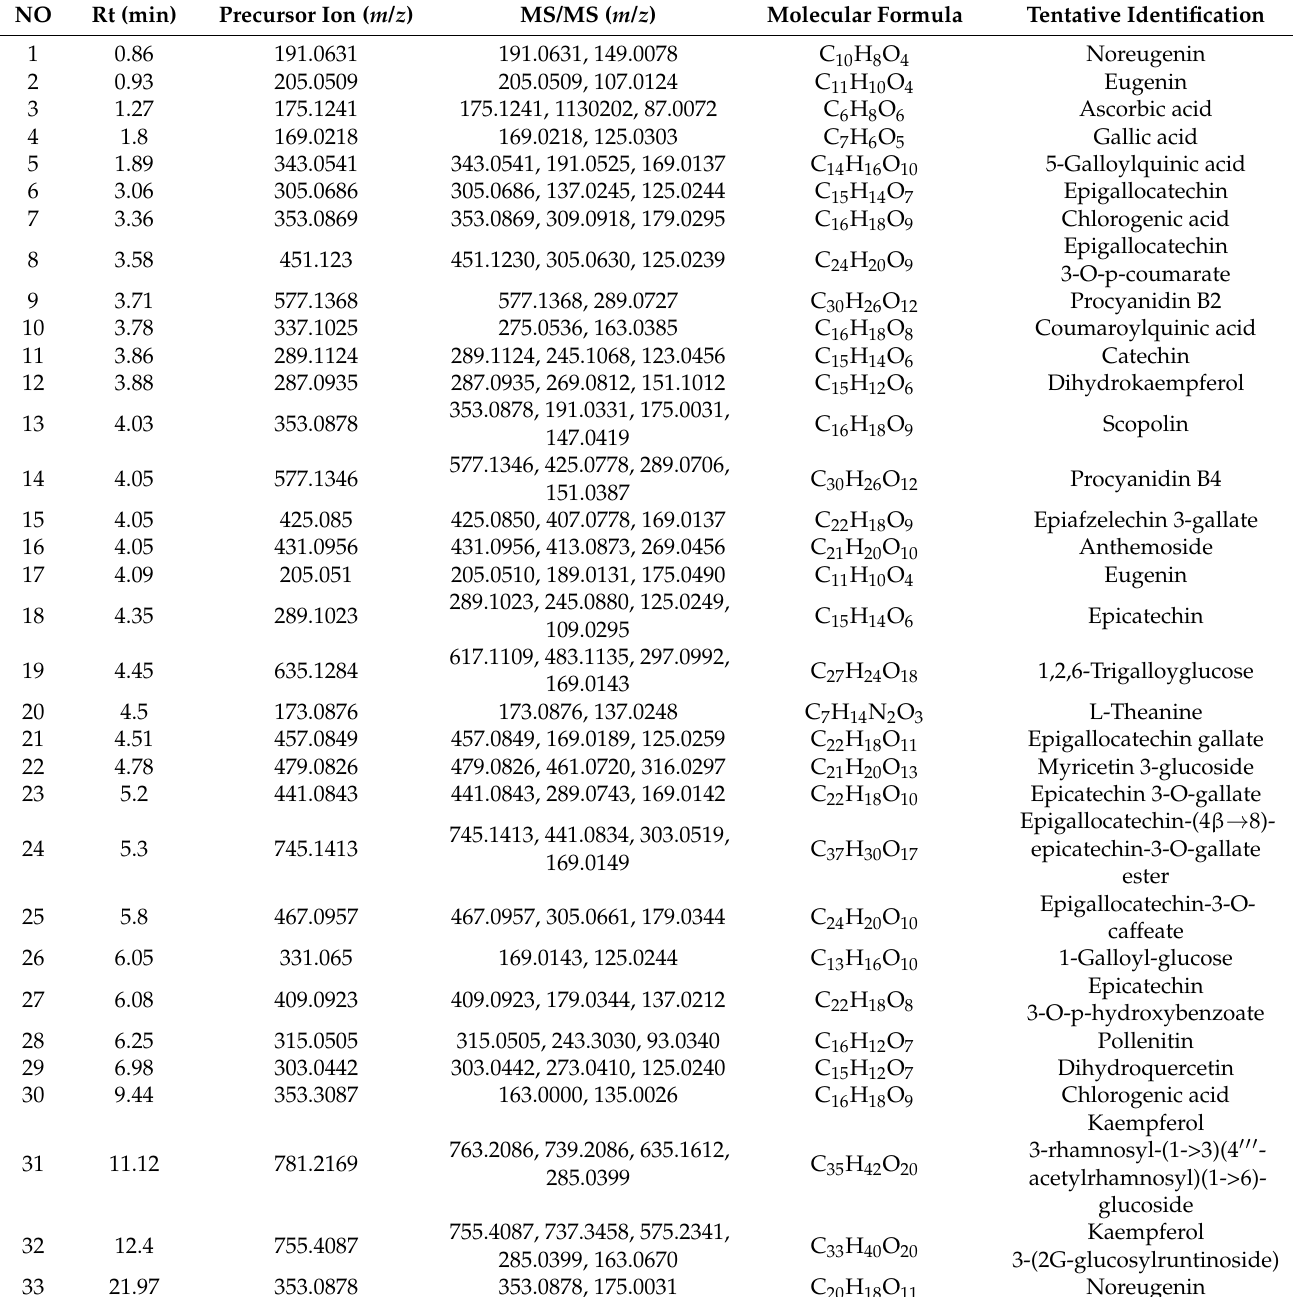
Table 2. Tentative LC-MS identification of the small molecules from polyphenol-rich Liupao extract